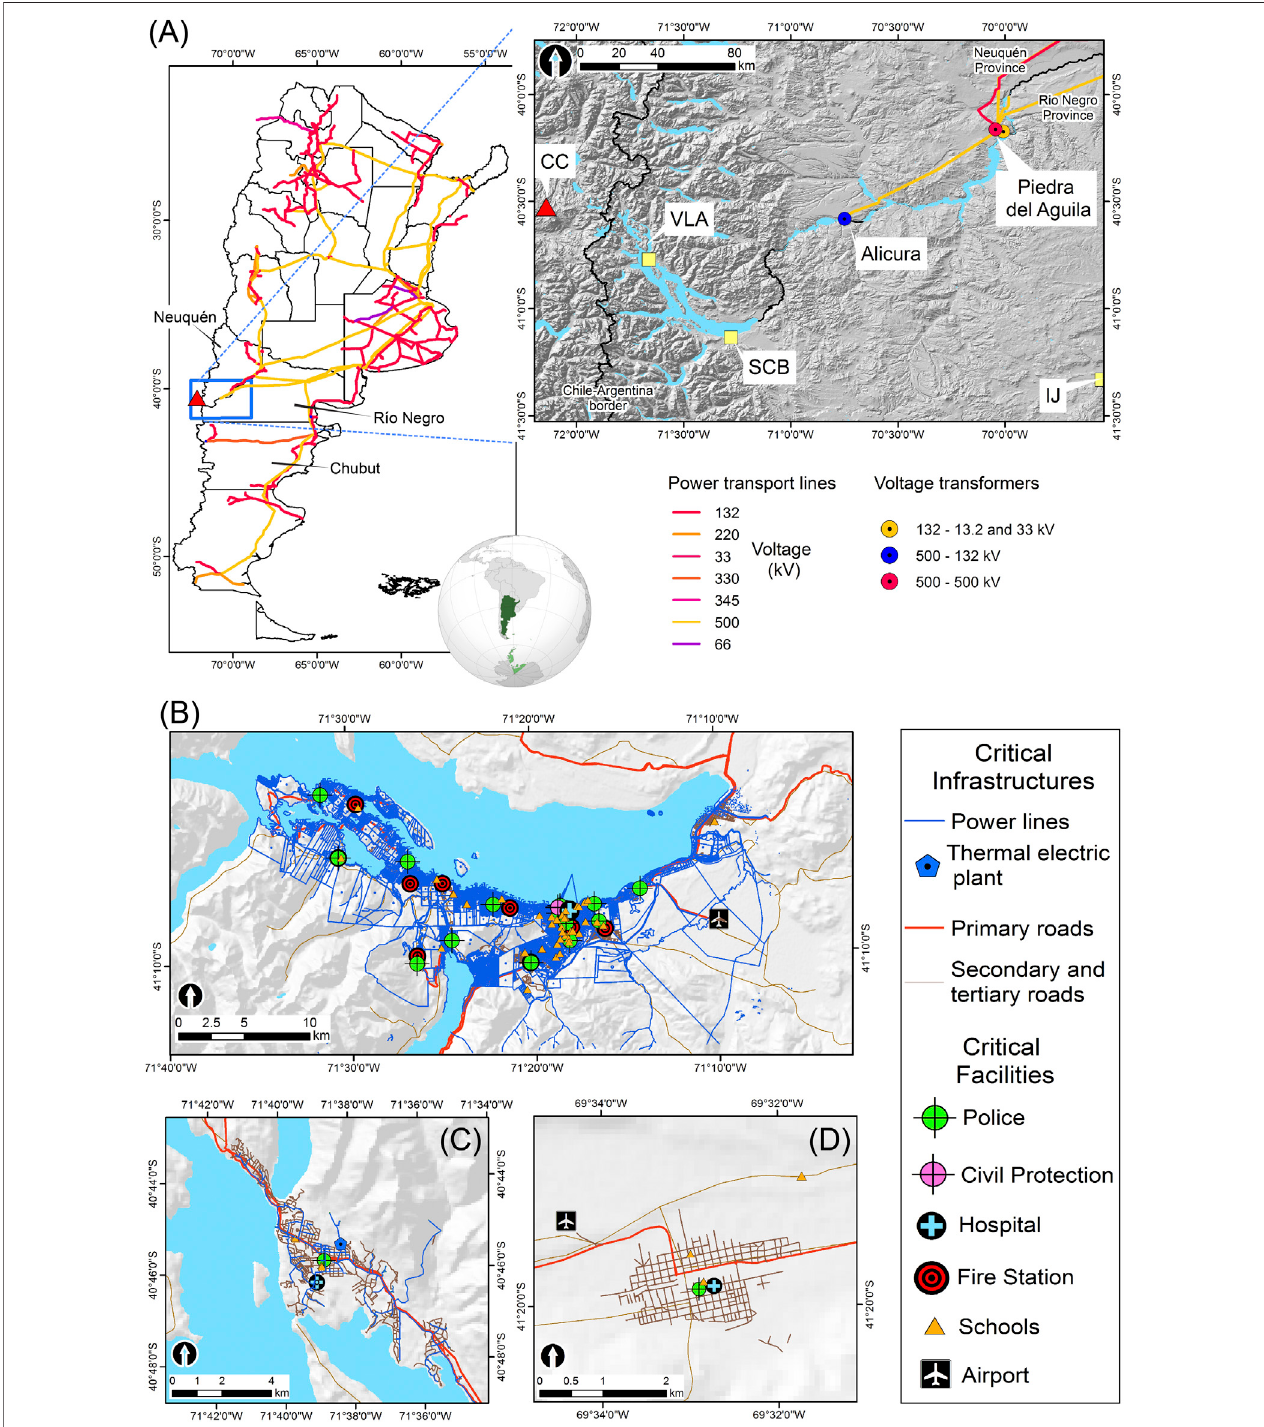
FIGURE 1 | (A) Location map and characteristics ofthe power system of Argentina and of the target localities ofthis study (San Carlos de Bariloche (SCB), Villa La Angostura (VLA), and Ingeniero Jacobacci (IJ) indicated by the yellow squares). CC indicates the Cordón Caulle volcano (red triangle). Power transport lines connected to the National System, transformers and nodes (Alicura, Piedra del Aguila) are shown (orange, blue and red circles). Critical infrastructures (CI) and facilities (CF) for (B) SCB, (C) VLA, and (D) IJ.